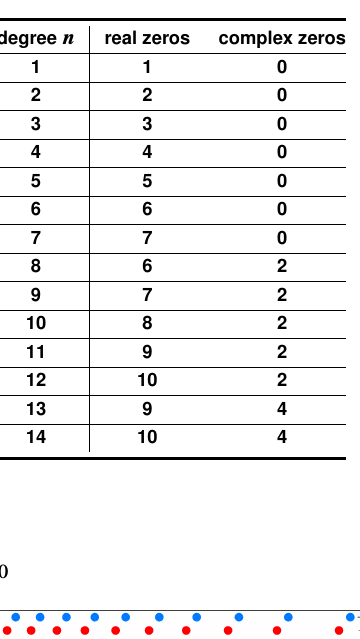
Table 1. Numbers of real and complex zeros of B n .x;4/